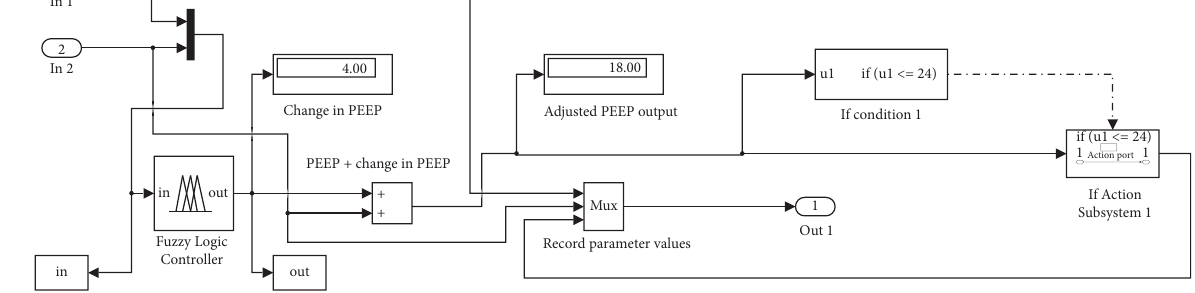
Figure 2: FiO 2 and PEEP fuzzy